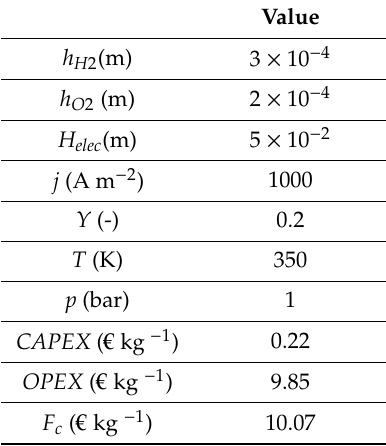
Table 9. Optimum DP with their associated hydrogen cost for IC s = 800 € m − 2 , EC = 17 c € kWh − 1 , r = 25 µ m and R memb = 3.23 × 10 − 5 Ohm m 2 .